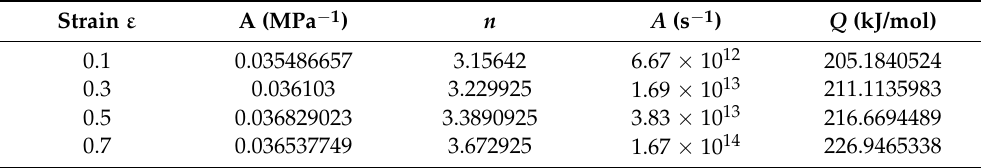
Table 2. Parameters of the constitutive equation under different strains for the SiCp/6013 composites. Strain